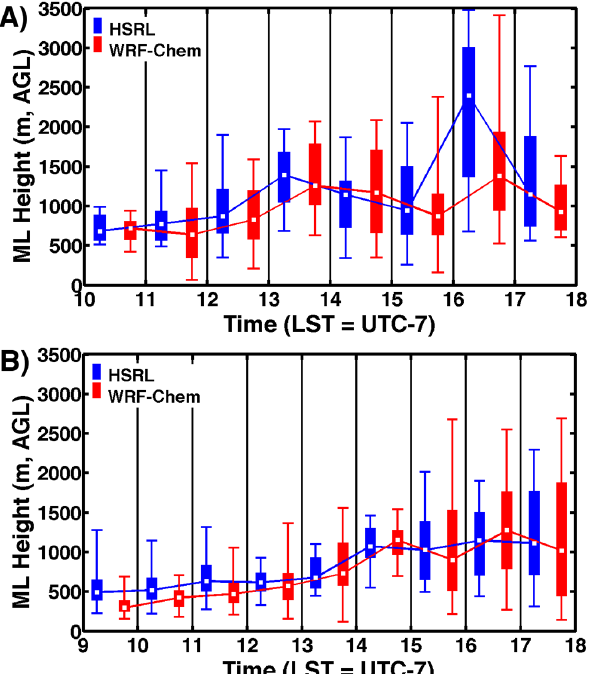
Figure 8. Diurnal variation for HSRL aerosol ML heights and WRF-Chem thermodynamic ML heights over the entire A) CalNex and B) CARES campaigns. Filled boxes denote the 25th and 75th percentiles and vertical lines denote the 5th and 95th percentiles. Lines connecting the white dots denote the median value for each hour. The blue and red boxes are gridded by time and offset for